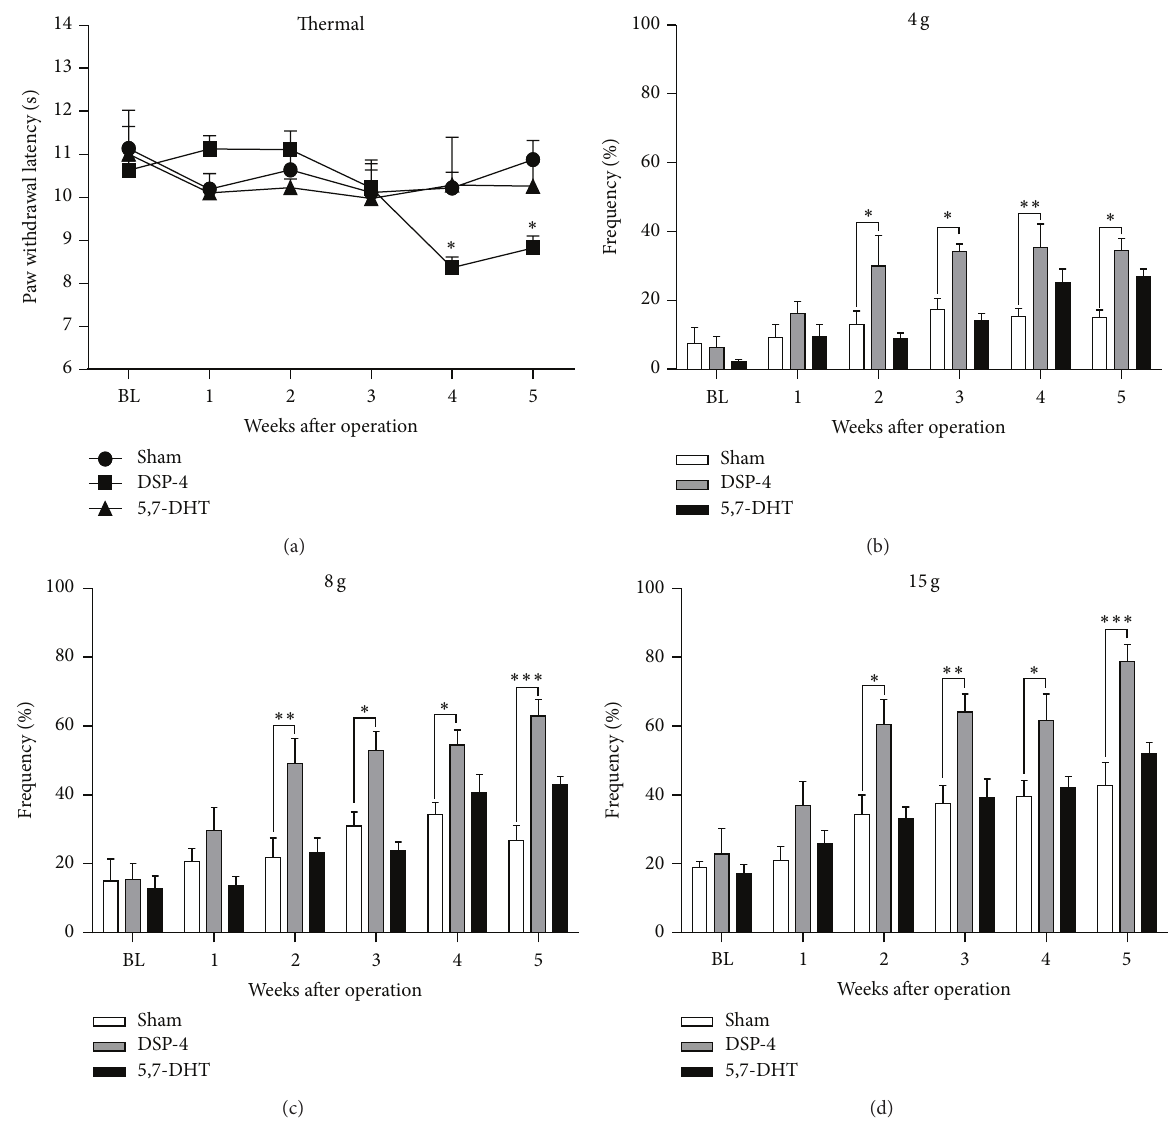
Figure 4: Effects of DSP-4 or 5,7-DHT injection alone on thermal and mechanical sensitivity in rats. (a) Compared to the sham group, paw thermal withdrawal threshold was decreased on the 4th week after bilateral ICV injection of DSP-4 (100 𝜇 g/4 𝜇 L in each side), but not 5,7- DHT (100 𝜇 g/4 𝜇 L in each side). ((b)–(d)) Mechanical hypersensitivity was significantly induced from the 2nd week of the end of testing after ICV injection DSP-4, but not 5,7-DHT ( ∗ 𝑃 < 0.05 , ∗∗ 𝑃 < 0.01 , and ∗∗∗ 𝑃 < 0.001 compared to the sham group, 𝑛 = 6-7 for each group).